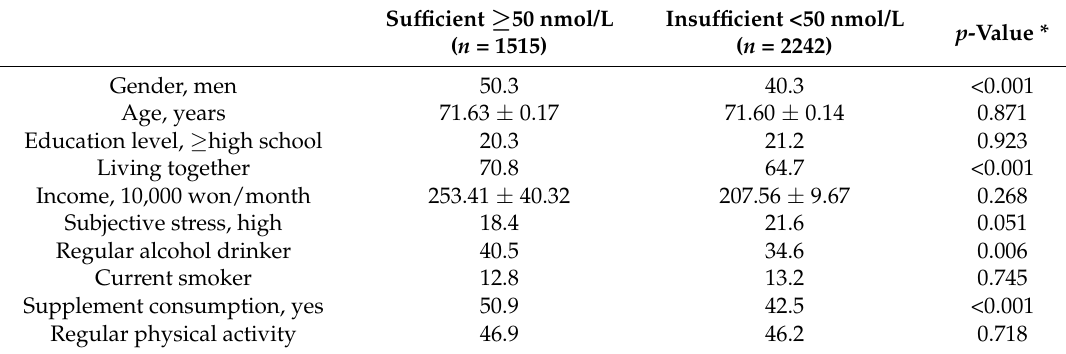
Table 1. General characteristics according to the 25-hydroxyvitamin D